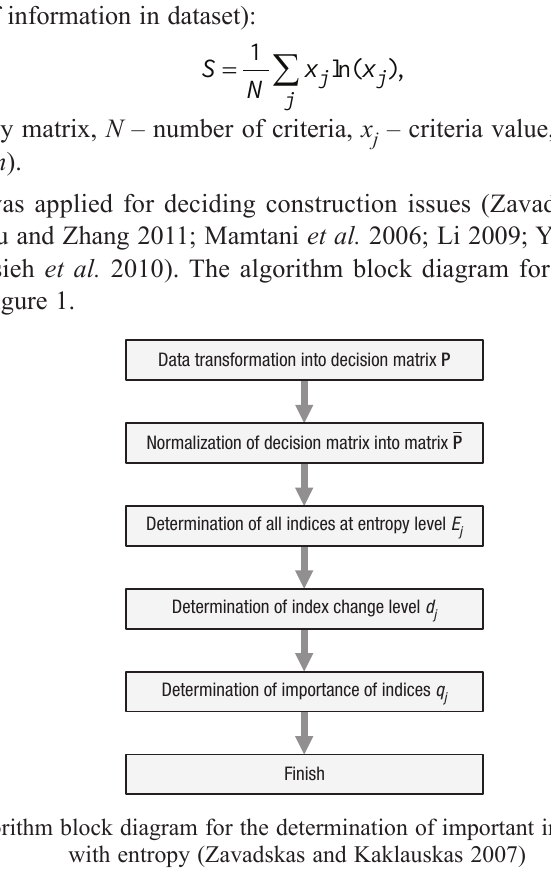
Fig. 1. The algorithm block diagram for the determination of important indices in accordance with entropy (Zavadskas and Kaklauskas 2007)